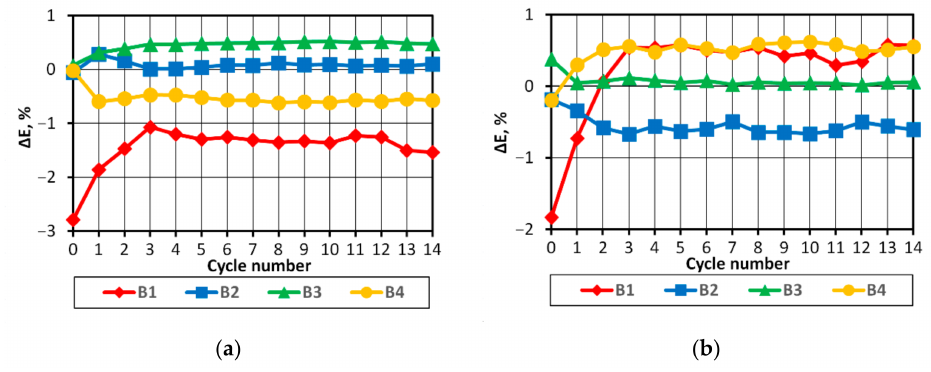
Figure 11. Differences in energy in successive discharging/charging cycles, as calculated in accor- dance with the formula (10): ( a ) discharging; ( b ) charging.